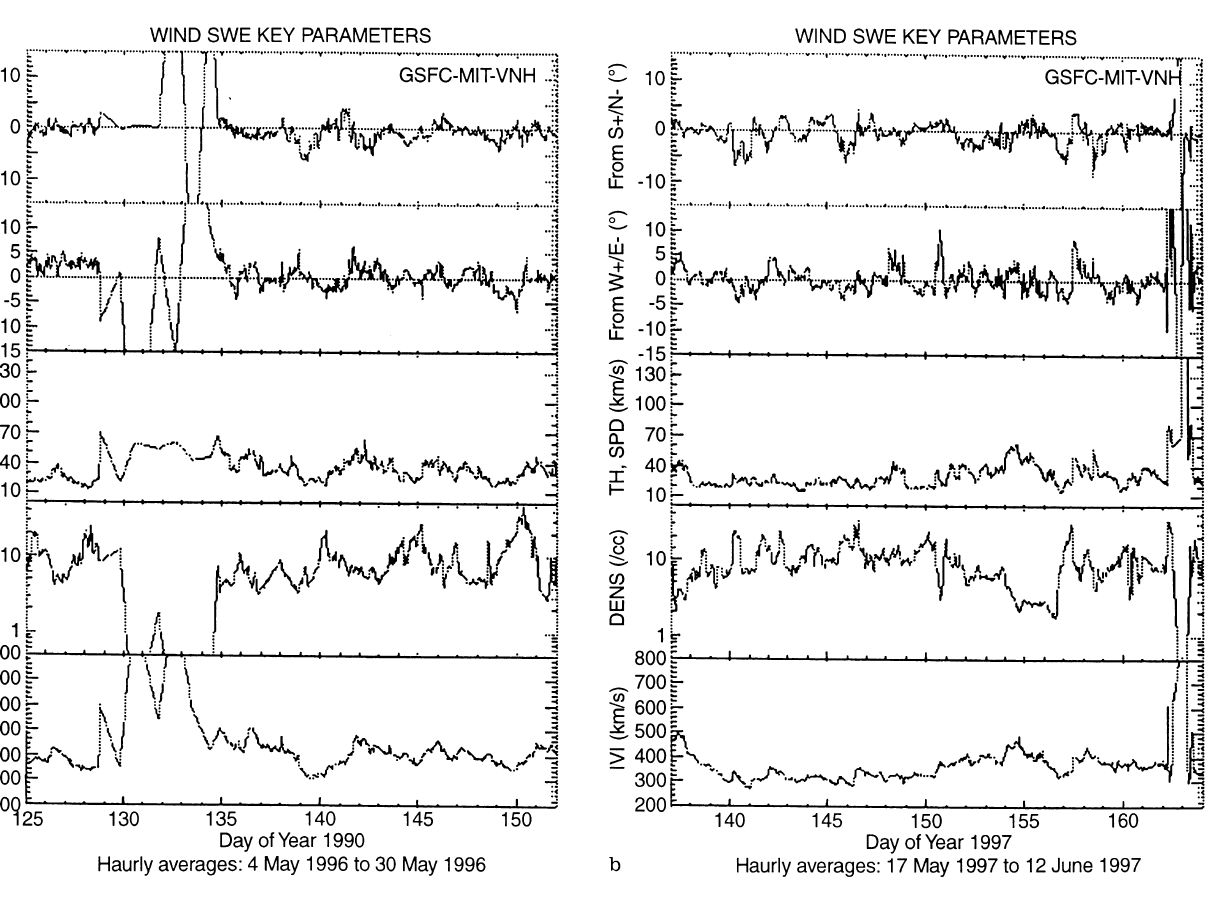
interaction region. b Measurements of solar wind parameters at 1 AU (215 R) from the Wind spacecraft, 17 May 1996–12 June 1997. The compression region observed by EISCAT on 23 May 1997 intersected the orbit of the Wind spacecraft between day 150 and day 151 of the year (30–31 May) when Wind detected intermediate flow velocities ( (cid:24) 440 km s ) 1 ) and enhanced